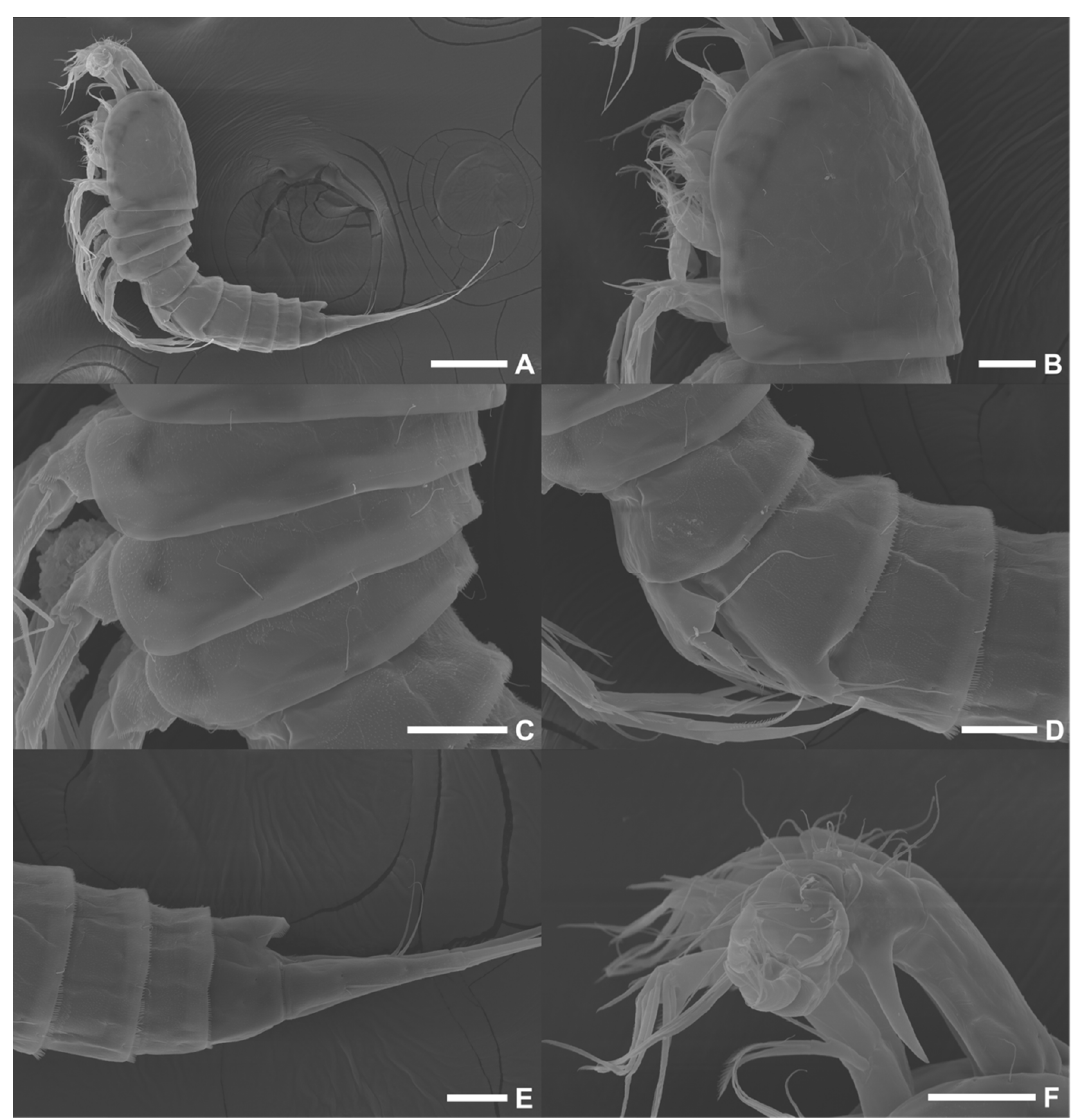
Figure 15. Scanning electron microscopy images of Phyllopodopsyllus saywakimi sp. nov. male (paratype 12) in lateral view: ( A ) habitus; ( B ) cephalothorax; ( C ) second to fourth prosomites; ( D ) first to third urosomites, P5, and P6; ( E ) fourth urosomite to anal somite and caudal rami; ( F ) antennule. Scale bars: ( A ) 100 µm; ( B – D ) 30 µm; ( E , F ) 20 µm.